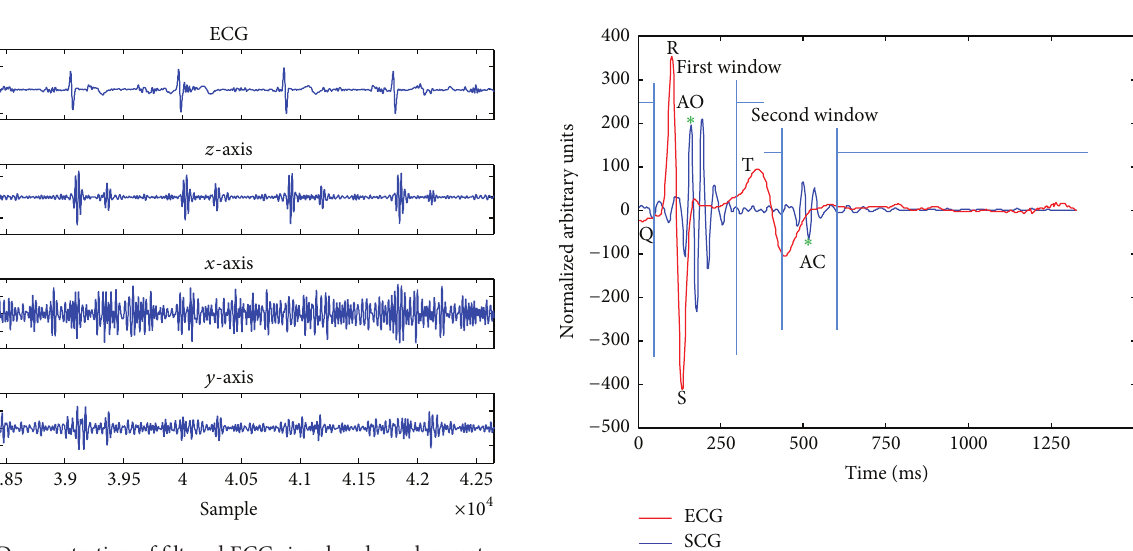
Figure 4: Demonstration of filtered ECG signal and accelerometer signals from different axes.